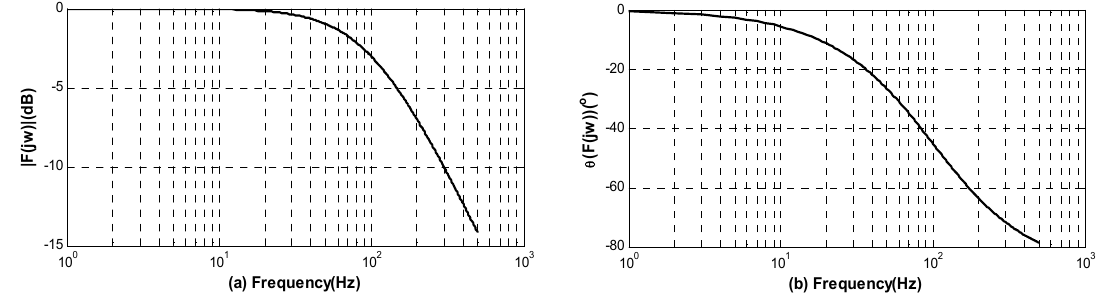
Figure 3. Normalized Bode diagram ( a ) Frequency-amplitude characteristic curve; and ( b ) Frequency-phase characteristic curve.